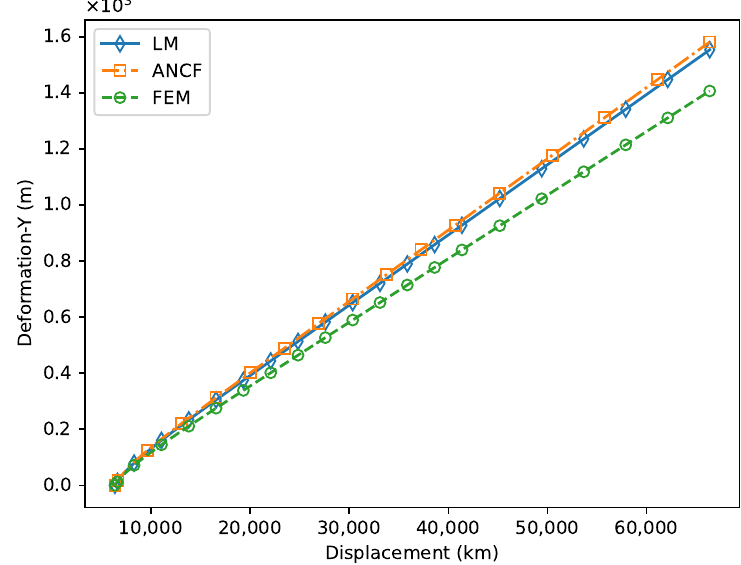
Figure 8. Deformation Y results of three method.